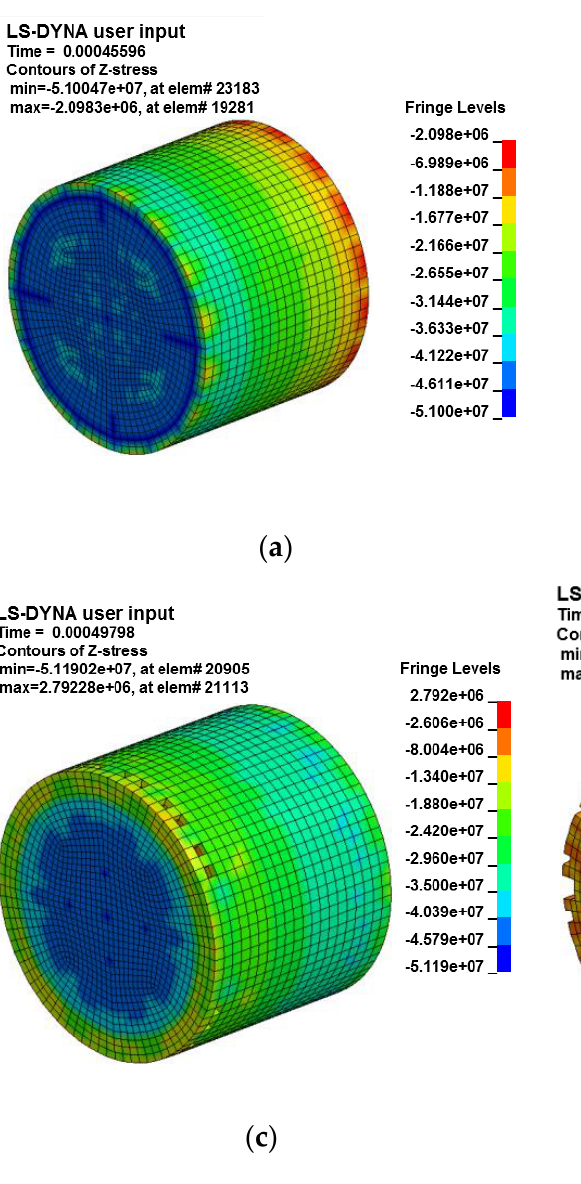
Figure 22. The simulation results of the specimen failure process. ( a ) Stress wave acting on the specimen. ( b ) Propagation of the stress wave to the specimen. ( c ) Sporadic unit failure. ( d ) Overall failure of the specimen.